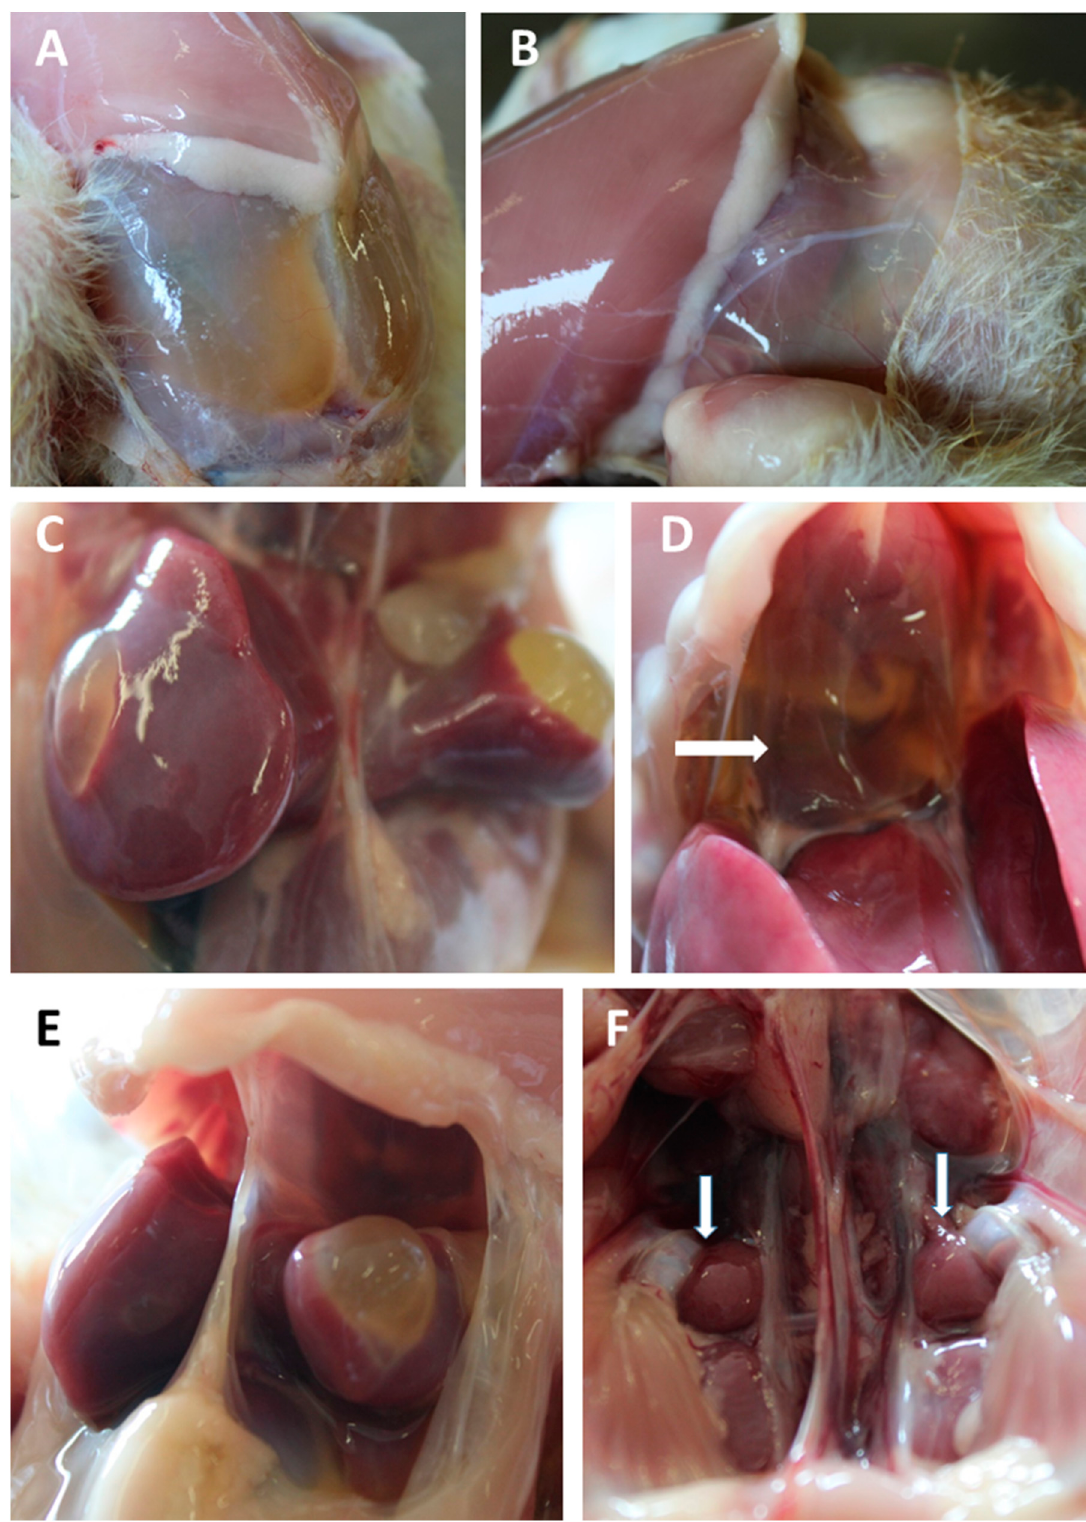
Figure 4. Effect of naturally contaminated diet on 14-days-old broiler chickens, showing: ( A , B ) abdominal fluid accumulation; ( C , E ) liver cysts; ( D ) hydropericardium (arrow); ( F ) enlarged kidneys (see arrows).